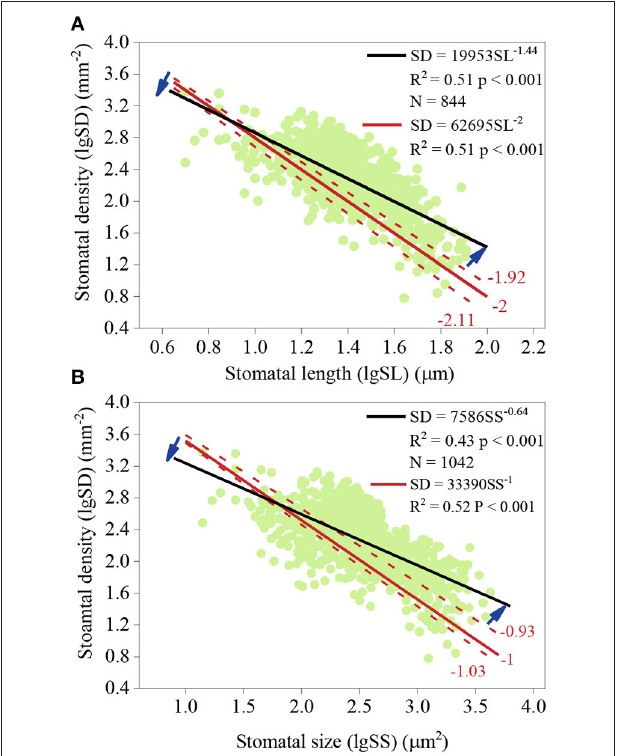
FIGURE 3 | Slope comparison of the relationship between stomatal density (SD) and stomatal length (SL) (A) and between SD and stomatal size (SS) (B) . (A) the log-log scaling slope of SD and SL. Dark blue arrows represent the divergence between the observed slope and the intrinsic slope, − 2. (B) the log-log scaling slope of SD and SS. The intrinsic slope was −